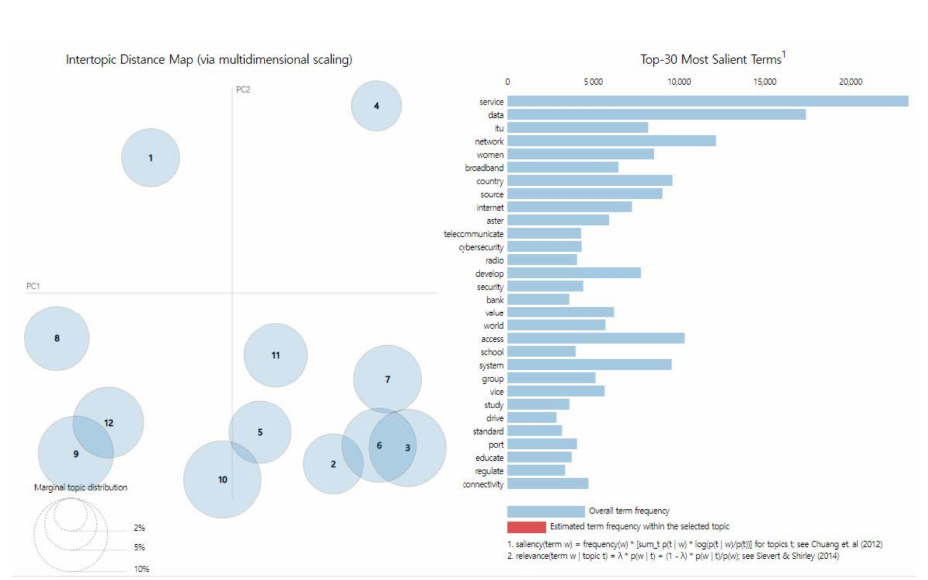
Figure 3. Distance map between